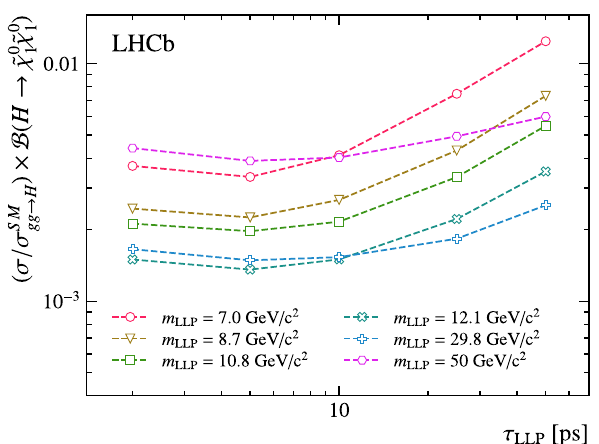
) × B ( H 0 → ˜ χ 0 ˜ χ 0 ) , assum- gg → H 1 1 LLP for different m LLP